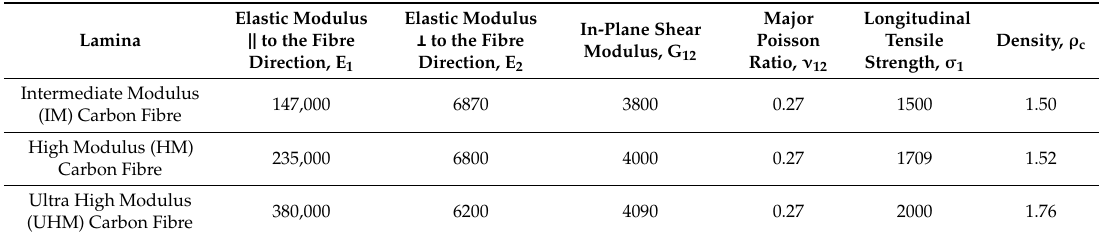
Table 5. The elastic properties of the unidirectional (UD) composite ply referred to the principal directions of the lamina.